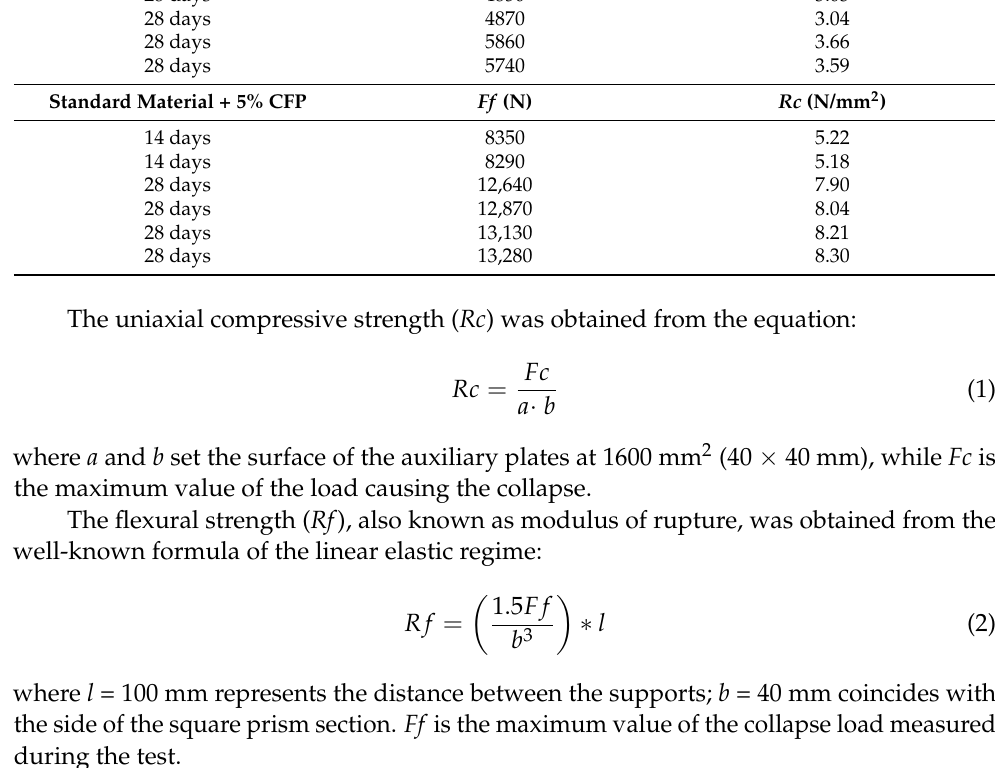
Standard Material + 5%